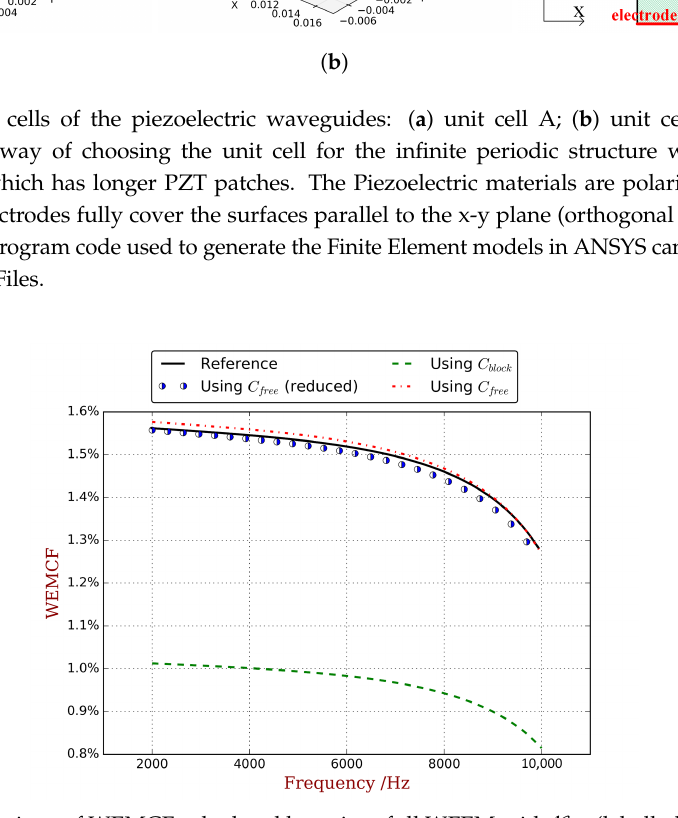
Figure 5. Comparison of WEMCF calculated by using: full WFEM with K W (labelled by ‘Reference’), full WFEM with K 1b (labelled by ‘using C block ’), full WFEM with K 1f (labelled by ‘using C free ’) and reduced waveshape with K 1f (labelled by ‘using C free